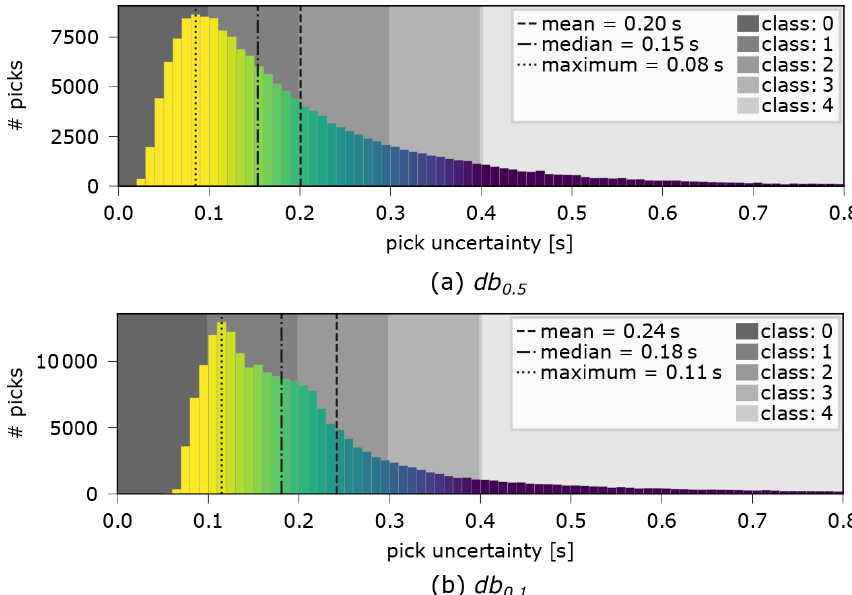
Figure 6. Pick uncertainty distribution of db 0 . 5 and db 0 . 1 , clipped at 0.8s. Uncertainties in the histograms are coloured identical to Fig. 7 for an easier